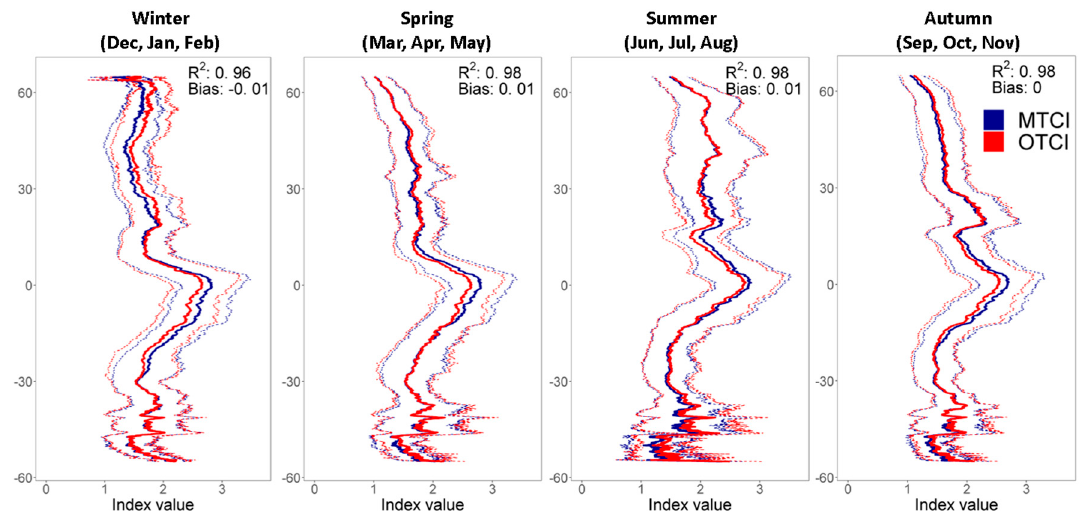
Figure 7. Latitudinal variation of Envisat MTCI (mean of 2002 to 2012) and Sentinel-3 OTCI (mean of 2016 to 2019) seasonal values. The seasons correspond to the northern hemisphere, for reference months are added in brackets. Blue and red lines show the mean latitudinal values and the dashed lines represents ±1 standard deviation.